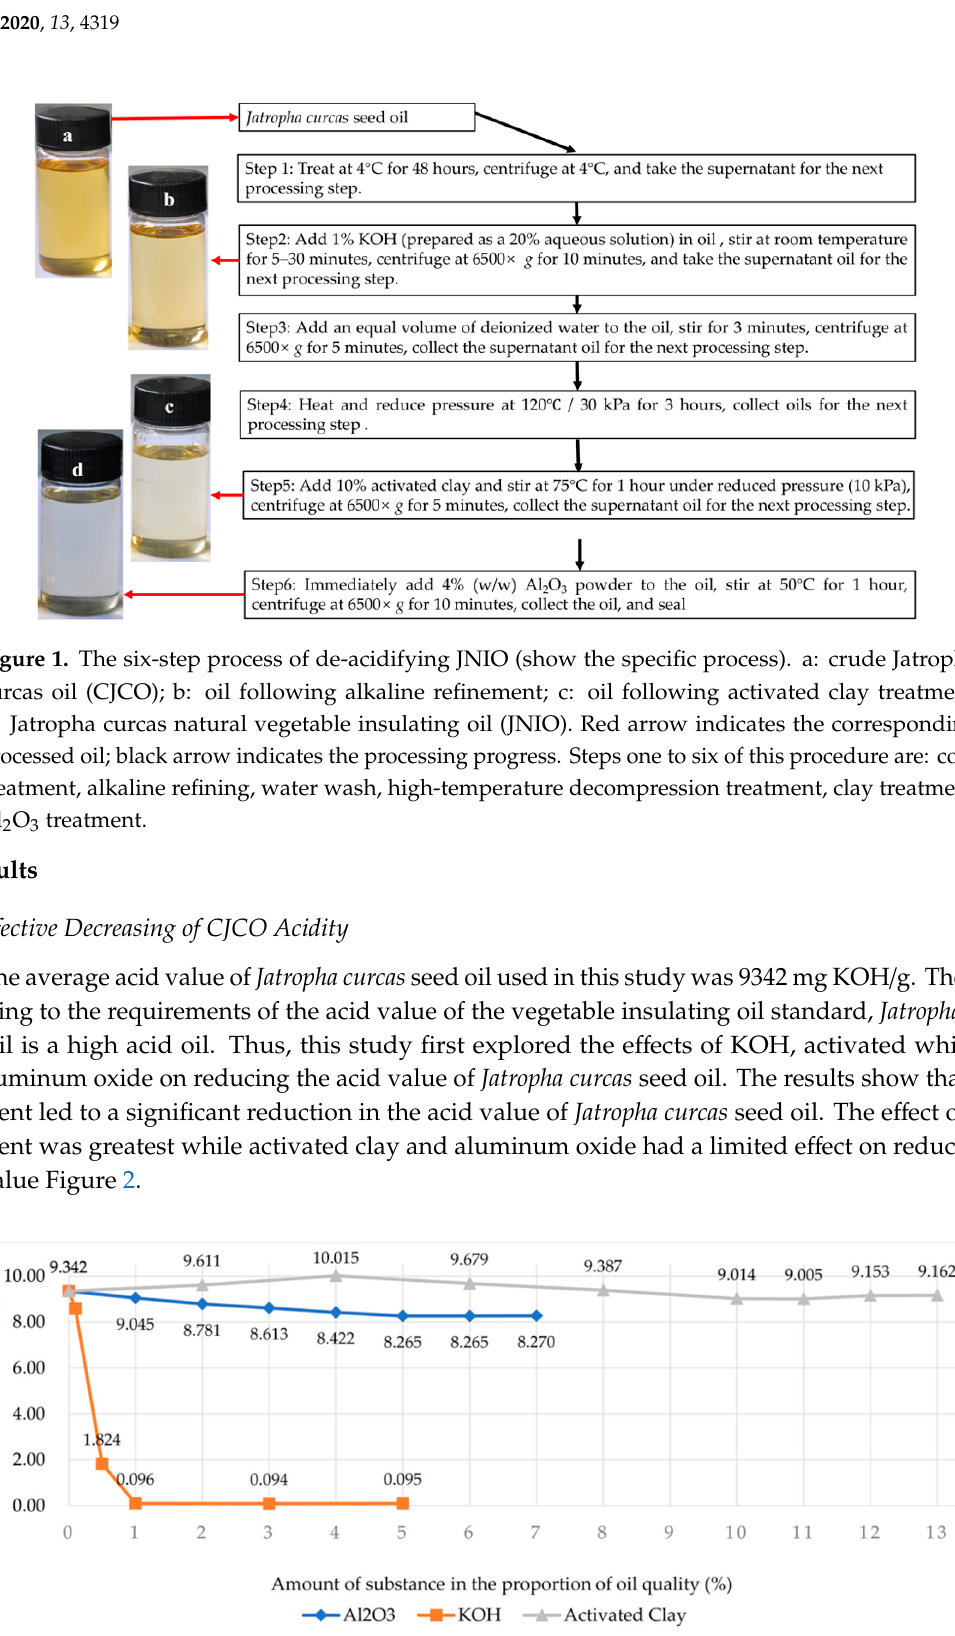
Figure 3. Effect of different alkali refining times on the acid value of CJCO. CJCO, crude Jatropha curcas oil. Alkaline refining of vegetable oils is usually performed between 50–90 °C [29,30]. Therefore, we compared the effect of alkaline refining (using 1% (w/w) KOH) at room temperature vs. at 65 °C on the acid value of CJCO. The results showed that the acid value of CJCO treated at 65 °C reached 0.095 mg KOH/g, which was not significantly different from the acid value (0.096 mg KOH/g) treated at room temperature. However, alkaline refining at room temperature resulted in a better separation of the soap base from the oil than when the procedure was carried out at 65 °C (Figure 4). When the alkaline refining reaction was done at room temperature, the oil and soap base could be separated by centrifugation at 6500× g for 5 min resulting in a clear, light yellow oil with improved color compared to CJCO (Figure 4a,b). However, when Jatropha seed oil was subjected to alkaline refining at 65 °C, and then centrifuged at 12,000× g for 30 min at room temperature immediately or after 1 h, the oil and soap base were still mixed together and became cloudy (Figure 4c). That is, after CJCO was subjected to alkaline refining at 65 °C, even if the centrifugation speed and time were increased, the separation of the oil and soap base was poor. Therefore, for Jatropha curcas seed oil, alkaline refining at room temperature not only greatly reduced the acid value of the oil, but also resulted in better separation of the oil and soap base than when the procedure was done at 65 °C.